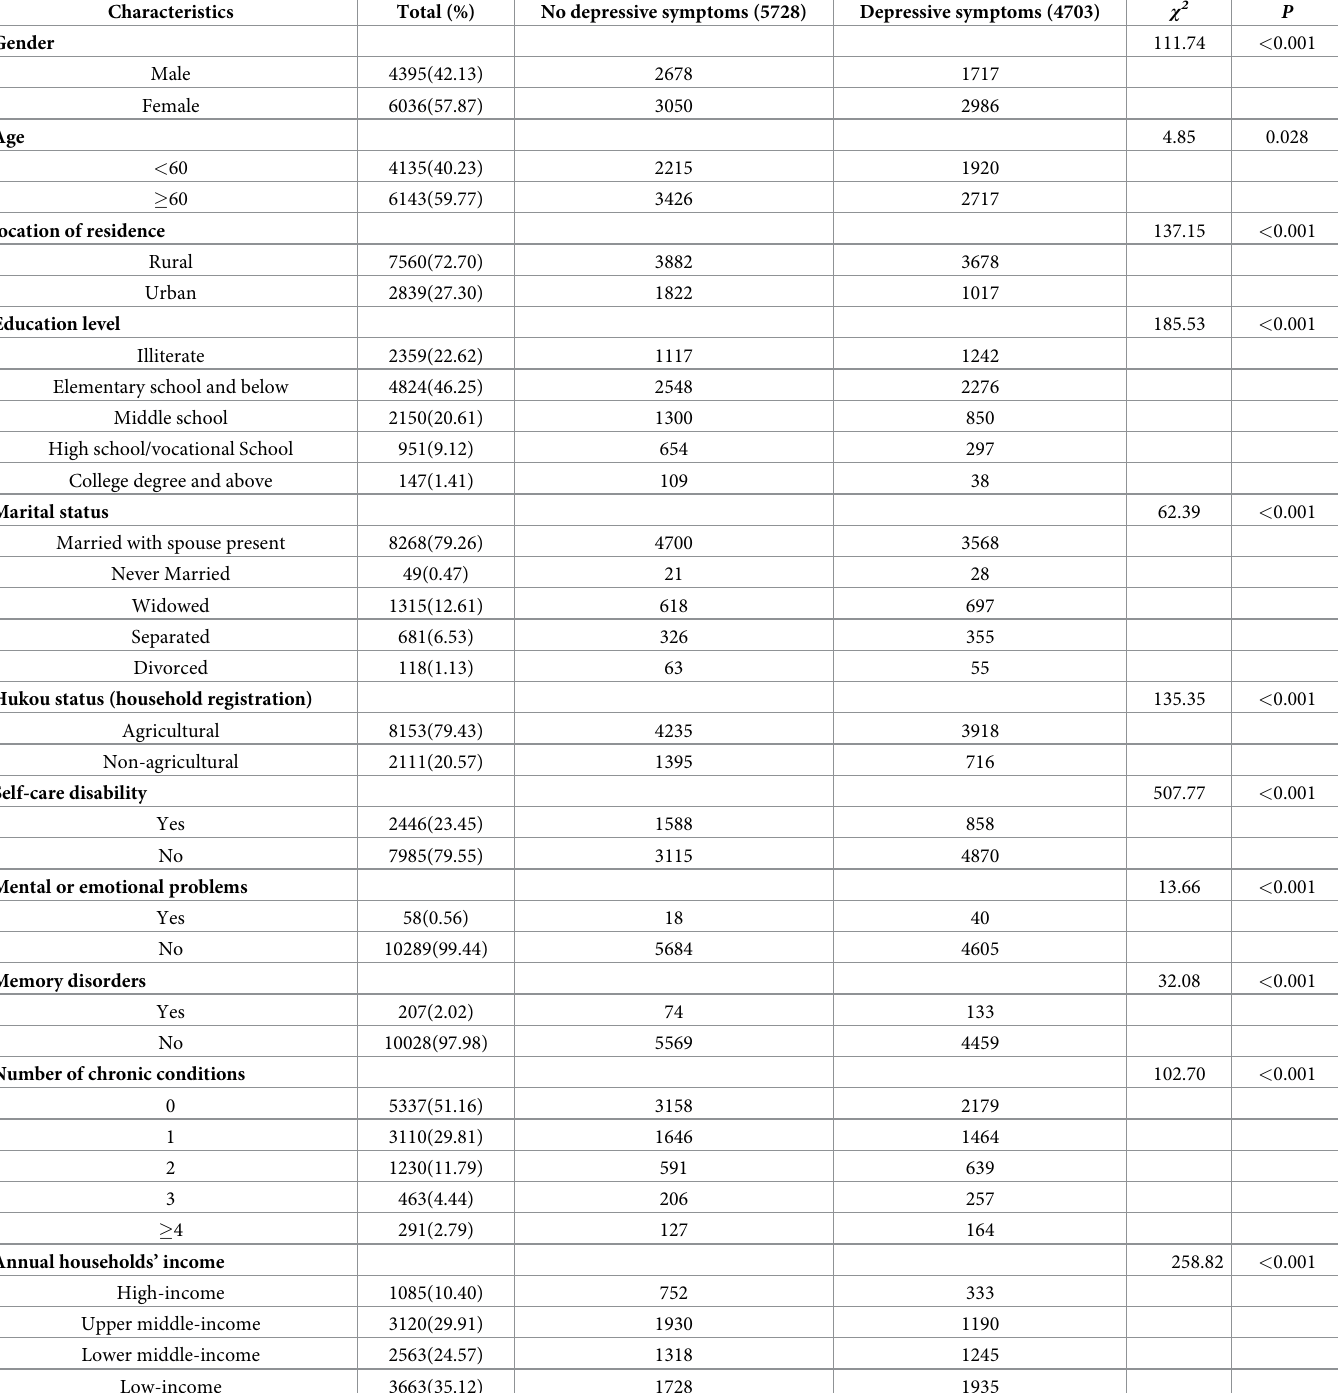
Table 1. Sample characteristics of middle- and older-aged Chinese